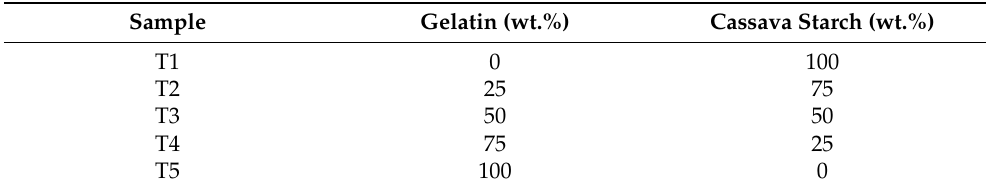
Table 4. Simplex-lattice experimental design for the formation of the cassava starch/gelatin composite